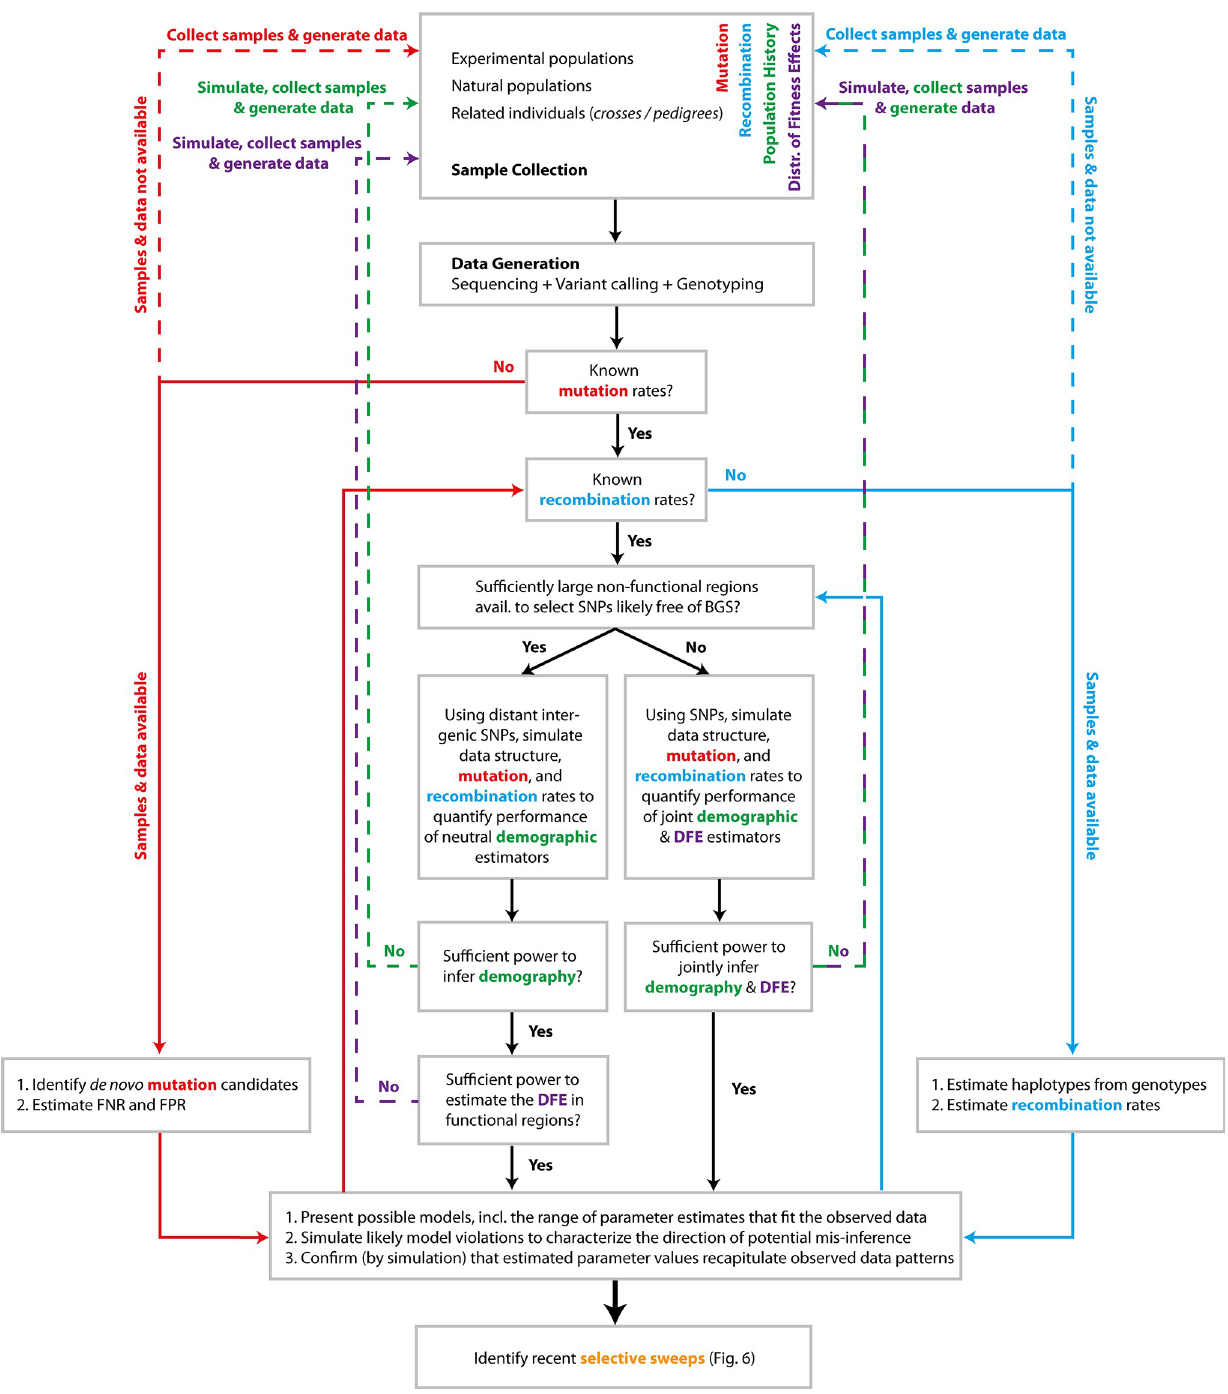
Fig 5. Diagram of important considerations in constructing a baseline model for genomic analysis. Considerations related to mutation rate are coded in red, recombination rate in blue, demographic history in green, and the DFE in purple—as well as combinations thereof. Beginning from the top with the source of data collected, the arrows suggest a path that is needed to be considered. Dotted lines indicate a return to the starting point. DFE, distribution of fitness effects; FNR, false negative rate; FPR, false positive rate.